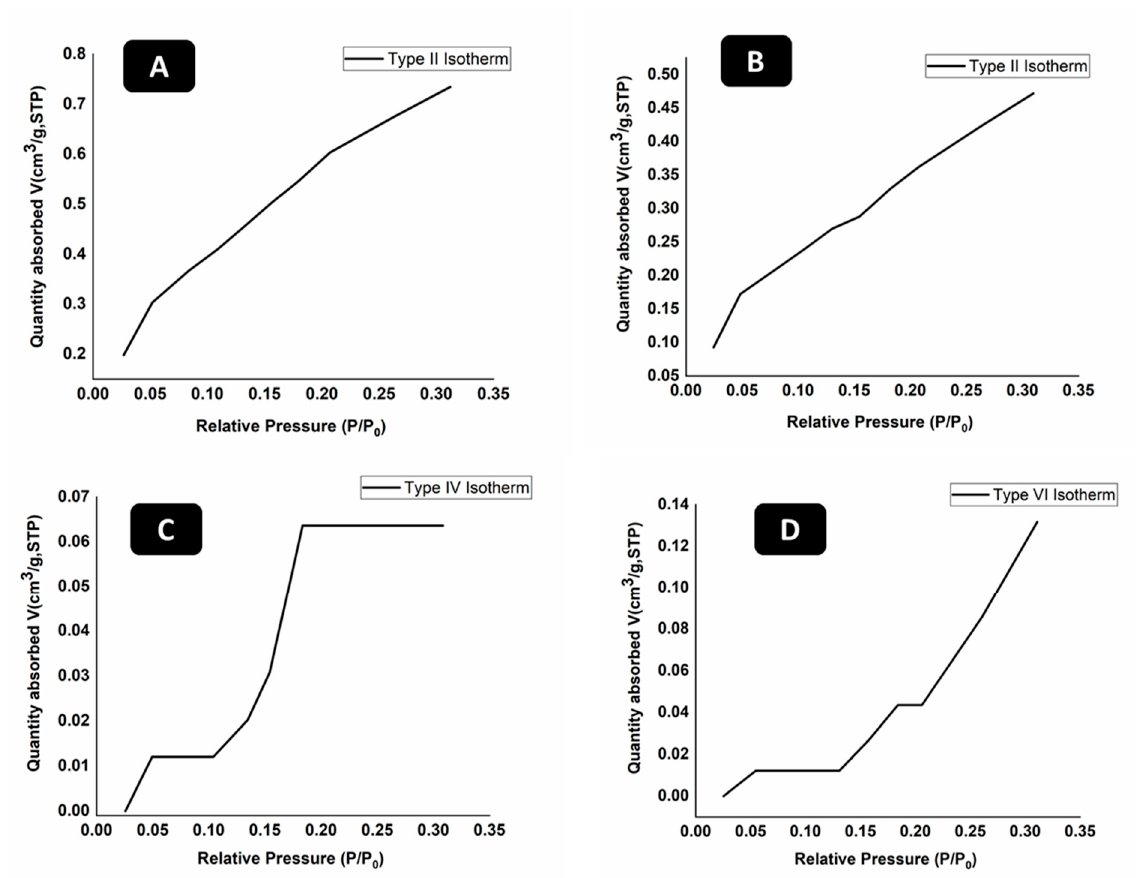
Figure 3. BET analysis of ( A ) 67CS33CHI, ( B ) 80CS20CHI, ( C ) 67CS33CHIGar, and ( D ) 80CS20CHIGar hydrogels.